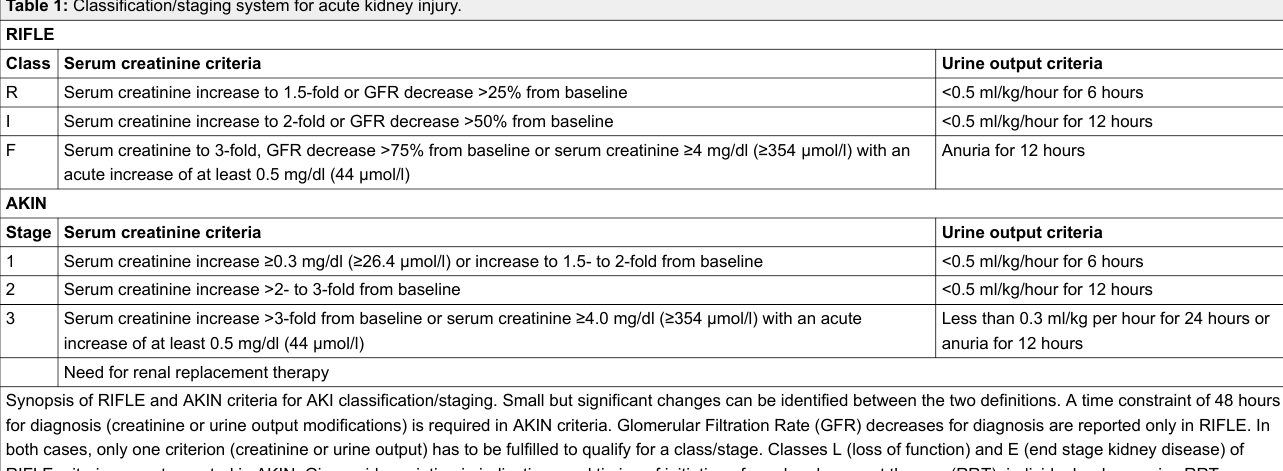
Table 1: Classification/staging system for acute kidney injury. RIFLE Class Serum creatinine criteria